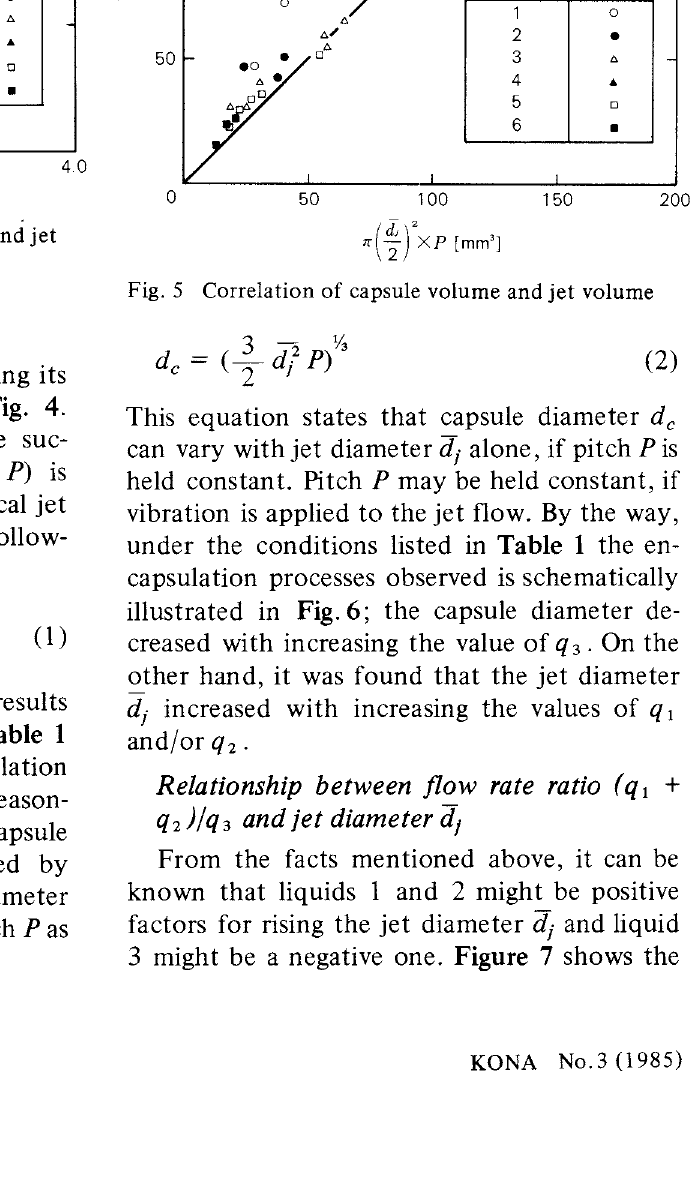
Fig. 4 Equality of volume between jet and capsule